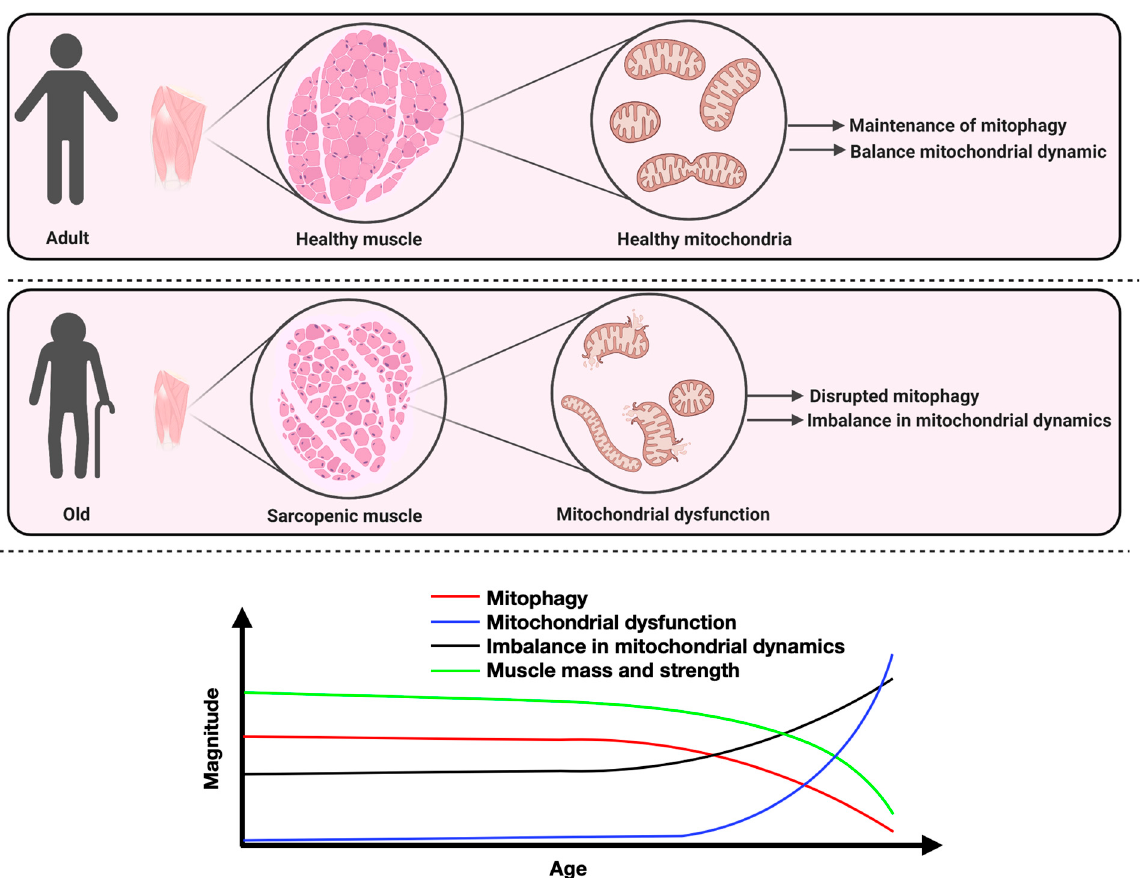
Figure 4. Conceptual model linking impairments in mitochondrial dynamics and mitophagy to the accumulation of mitochondria and the loss of muscle mass and function during aging. In healthy skeletal muscles, mitochondrial dynamics and mitophagy play central roles in maintaining mitochondrial integrity. The mitochondrial dynamics balance and mitophagy levels are represented by a black and red line, respectively; the blue line represents the level of mitochondrial dysfunction; the green line represents muscle mass and strength. Created with BioRender.com.